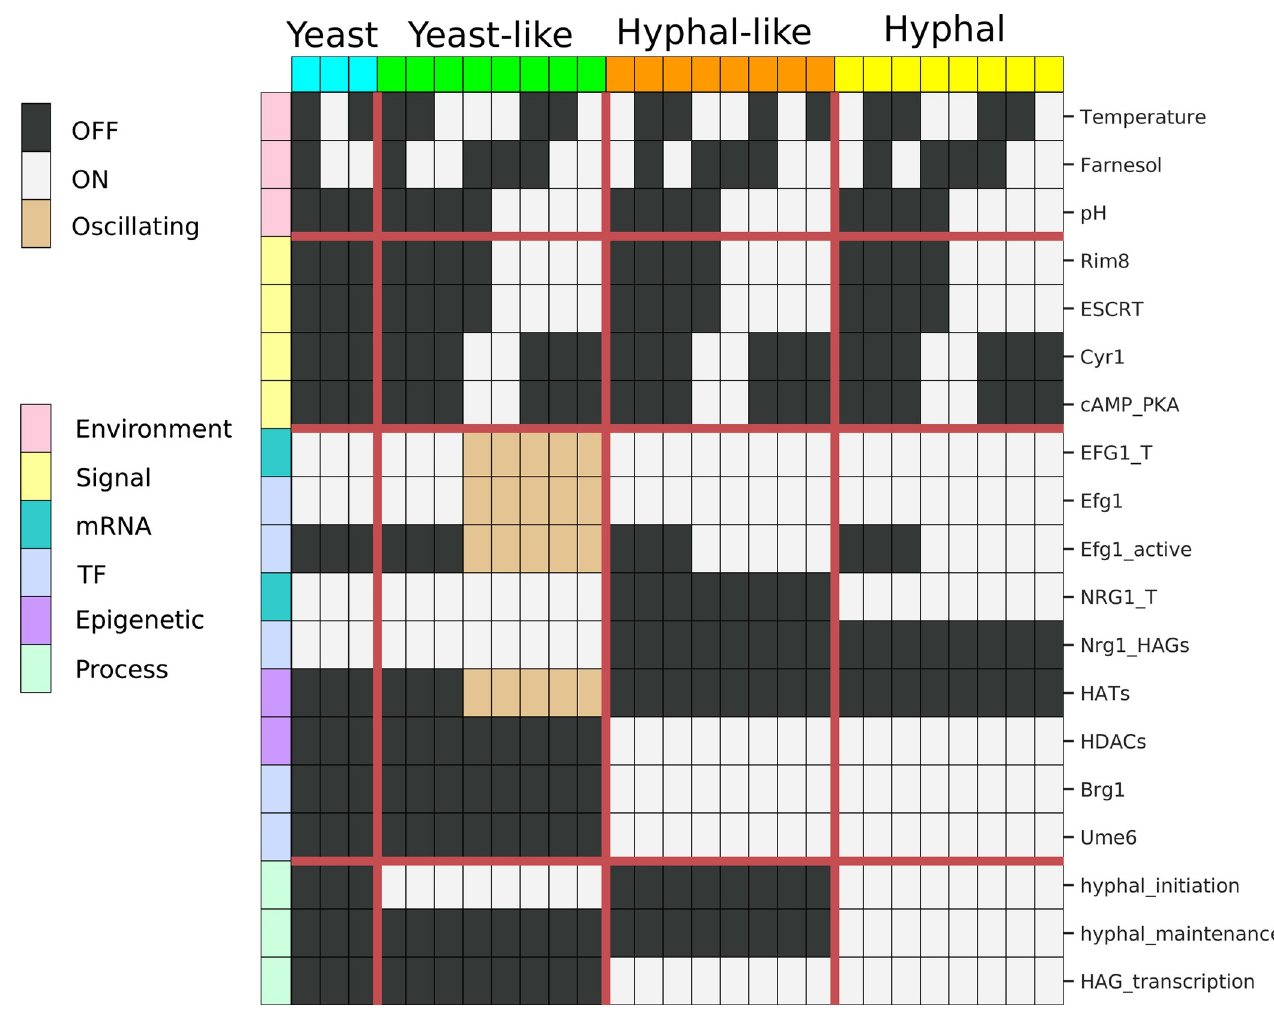
Fig 2. Visual summary of the 27 attractors of the YHT Boolean model. Each row corresponds to a network node and each column indicates an attractor. White indicates active (ON) nodes, black indicates inactive (OFF) nodes, and beige indicates nodes that oscillate. Individual attractors have been assigned to one of four phenotypes—yeast, yeast-like, hyphal-like, and hyphal—based on the status of the hyphal_initiation, hyphal_maintenance, and HAG_transcription nodes (see